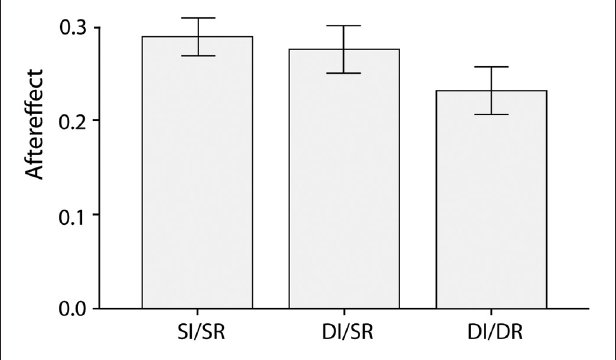
FIGURE 3 | Average emotion aftereffects for the three different combinations of adapting and test face (Same Identity/Same Race, Different Identity/Same Race, and Different Identity/Different Race) when the adapting and test faces were presented in gray scale.